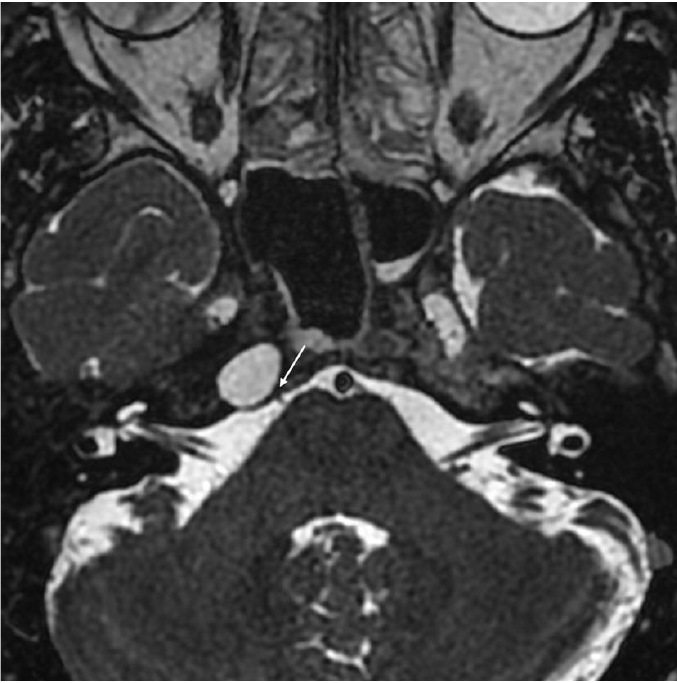
Figure 5. Axial T2-weighted MRI showing indirect compression of Dorello’s canal (white arrow) by a cholesterol granuloma of the petrous apex.